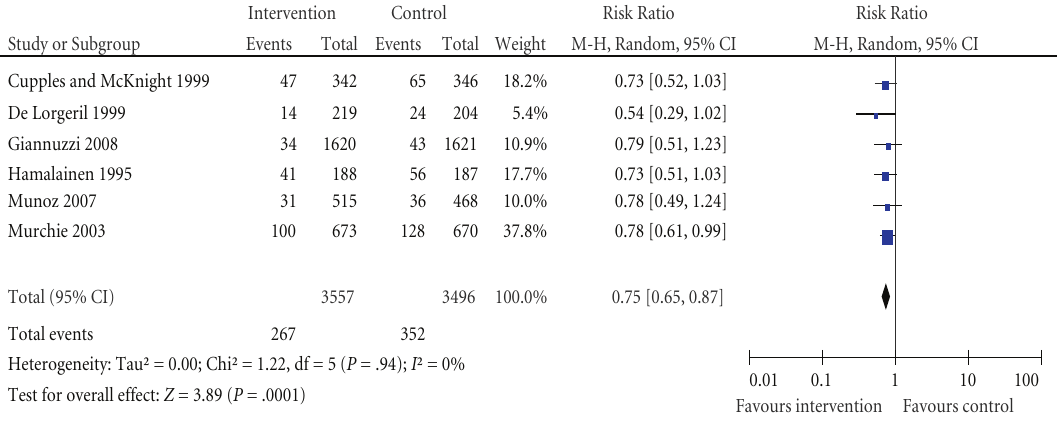
Figure 2: E ff ect of interventions on all-cause mortality: comparison of intervention versus control groups.